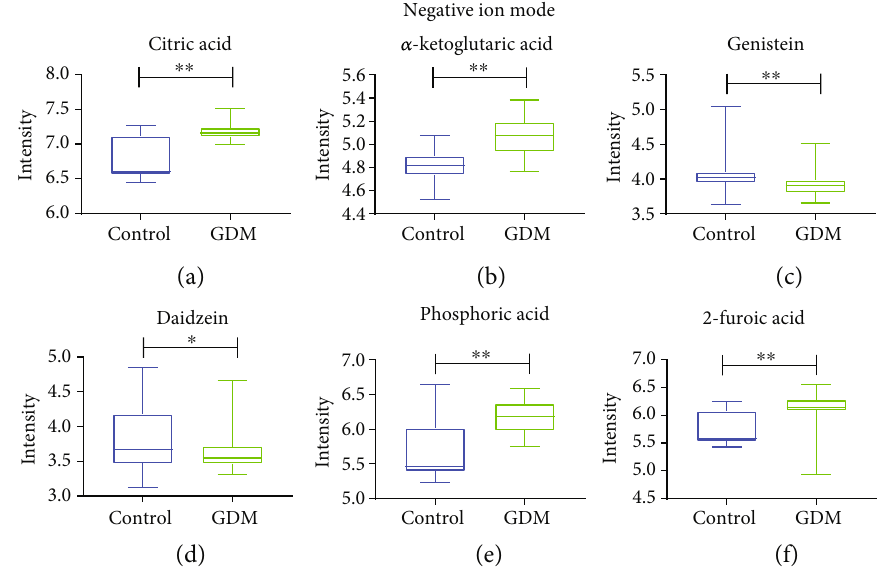
Figure 5: Boxplots of metabolites between control and GDM under negative ion mode. Student ’ s t -test for measurement data between two groups was performed for signi fi cant di ff erence. All data are expressed as the mean ± SEM , and the statistical signi fi cance level was set at ∗ p < 0 : 05 . ∗∗ p < 0 : 01